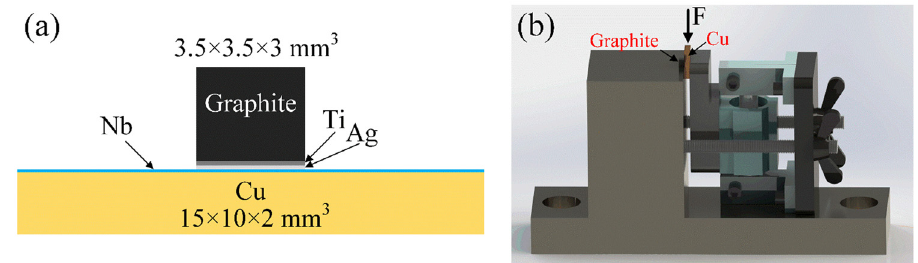
Figure 1: Schematic diagram: ( a ) assembling bonding parts and ( b ) shear test